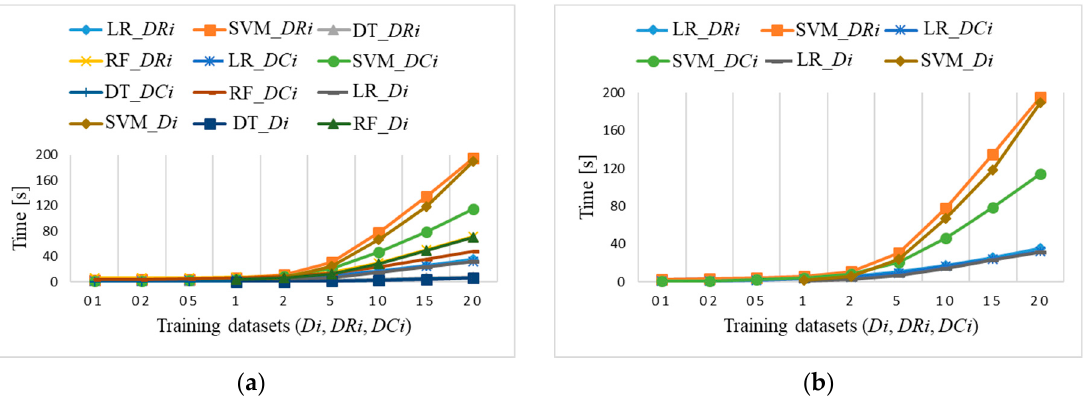
Figure 21. Raspberry Pi 4 training time for: ( a ) Di , DRi , DCi (coincidences of: RF_ Di and RF_ DRi ; DT_ Di , DT_ DRi , and DT_ DCi ; LR_ Di , LR_ DRi , and LR_ DCi ); ( b ) LR and SVM for Di , DRi , DCi (coincidence of LR_ Di , LR_ DRi , and LR_ DCi ).